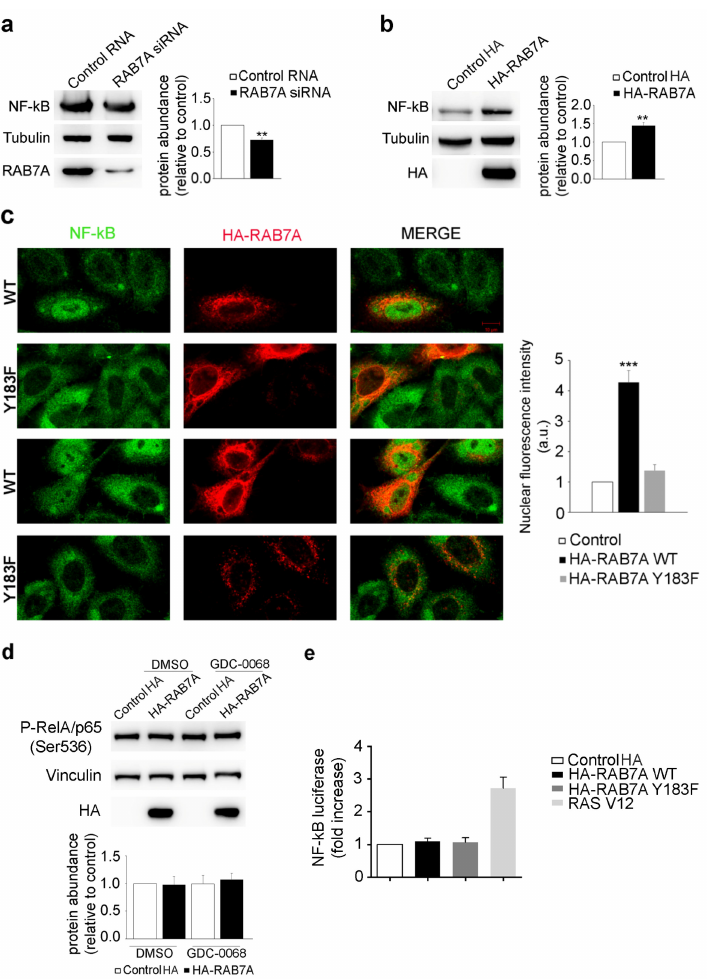
Figure 6. RAB7A affects NF-kB expression and localization. ( a ) HeLa cells were transfected with either control RNA or RAB7A siRNA, replated 72 h after transfection and then lysed after 48 h. ( b ) HeLa cells were transfected with plasmids encoding either HA or HA-RAB7A and lysed after 24 h. Lysates were subjected to Western blot analysis using anti-NF-kB, anti-tubulin, anti-RAB7A and anti-HA antibodies. The quantification of NF-kB is shown. Data represent the mean ± s.e.m. of at least three independent experiments. ( c ) HeLa cells were transfected with a plasmid coding for HA-RAB7A WT or HA-RAB7A Y183F and, 24 h after transfection, were analyzed by immunofluo- rescence using anti-HA (red) and anti-NF-kB (green) antibodies. Scale bar = 10 µ M. NF-kB nuclear fluorescence intensities of at least 50 cells per sample were measured using ImageJ. Data represent the mean ± s.e.m. of three independent experiments. Statistical analyses were performed using Student’s t test with control cells as referring sample. ( d ) HeLa cells were transfected with plasmids encoding either HA, HA-RAB7A WT or HA-RAB7A Y183F . Then, 24 h after transfection cells were treated with AKT inhibitor GDC-0068 1 µ M or DMSO for 24 h and then lysed. Lysates were subjected to Western blot analysis using anti-P-p65/RelA (Ser536), anti-vinculin and anti-HA antibodies. ( e ) HeLa cells were transfected with the NF-kB luciferase reporter vector and with different expression vectors. Twenty-four hours after transfection, cells were lysed and the luciferase activity was measured in cell extracts. Data are represented as fold induction of the normalized luciferase activity with respect to control cells transfected with GFP. All luciferase results represent the average ± S.D. of three independent experiments. All samples were read in triplicate. ** = p < 0.01; *** = p <